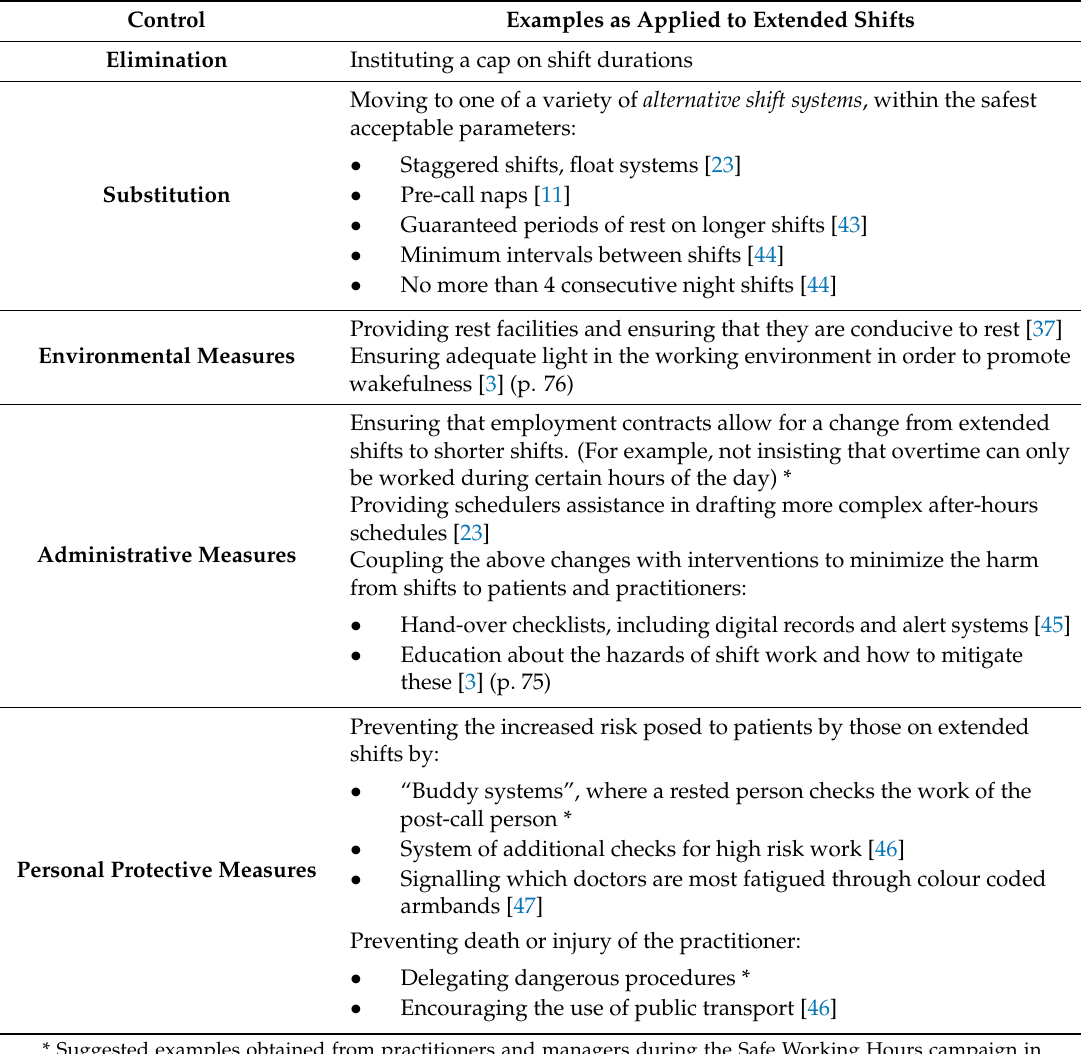
Table 1. Adapting the hierarchy of controls to extended